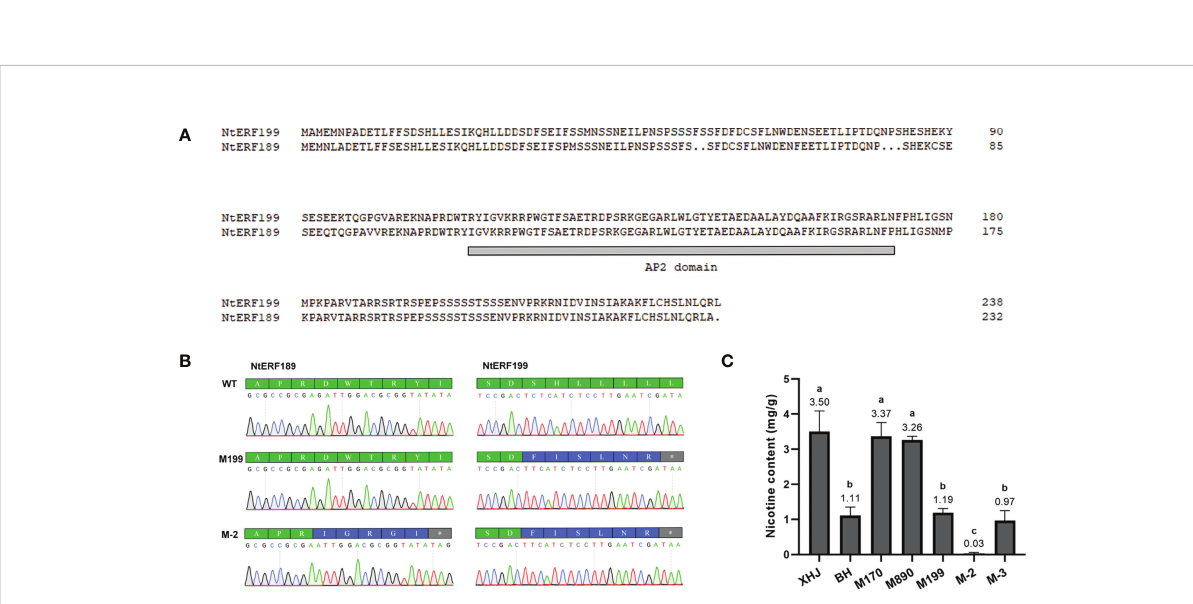
FIGURE 5 Validation of the association between two ERFs and nicotine content. (A) Alignment of NtERF199 and NtERF189 . The AP2 domain is indicated by a gray line. (B) Mutation of NtERF189 in M-2 and NtERF199 in M199 and M-2. Normal amino acids are marked in green. Mutated amino acids are marked in blue and stop codon is marked in grey. (C) Nicotine content of wildtype (XHJ, BH) and T2 homozygous mutants (M170, M890, M199, M-2, M-3).